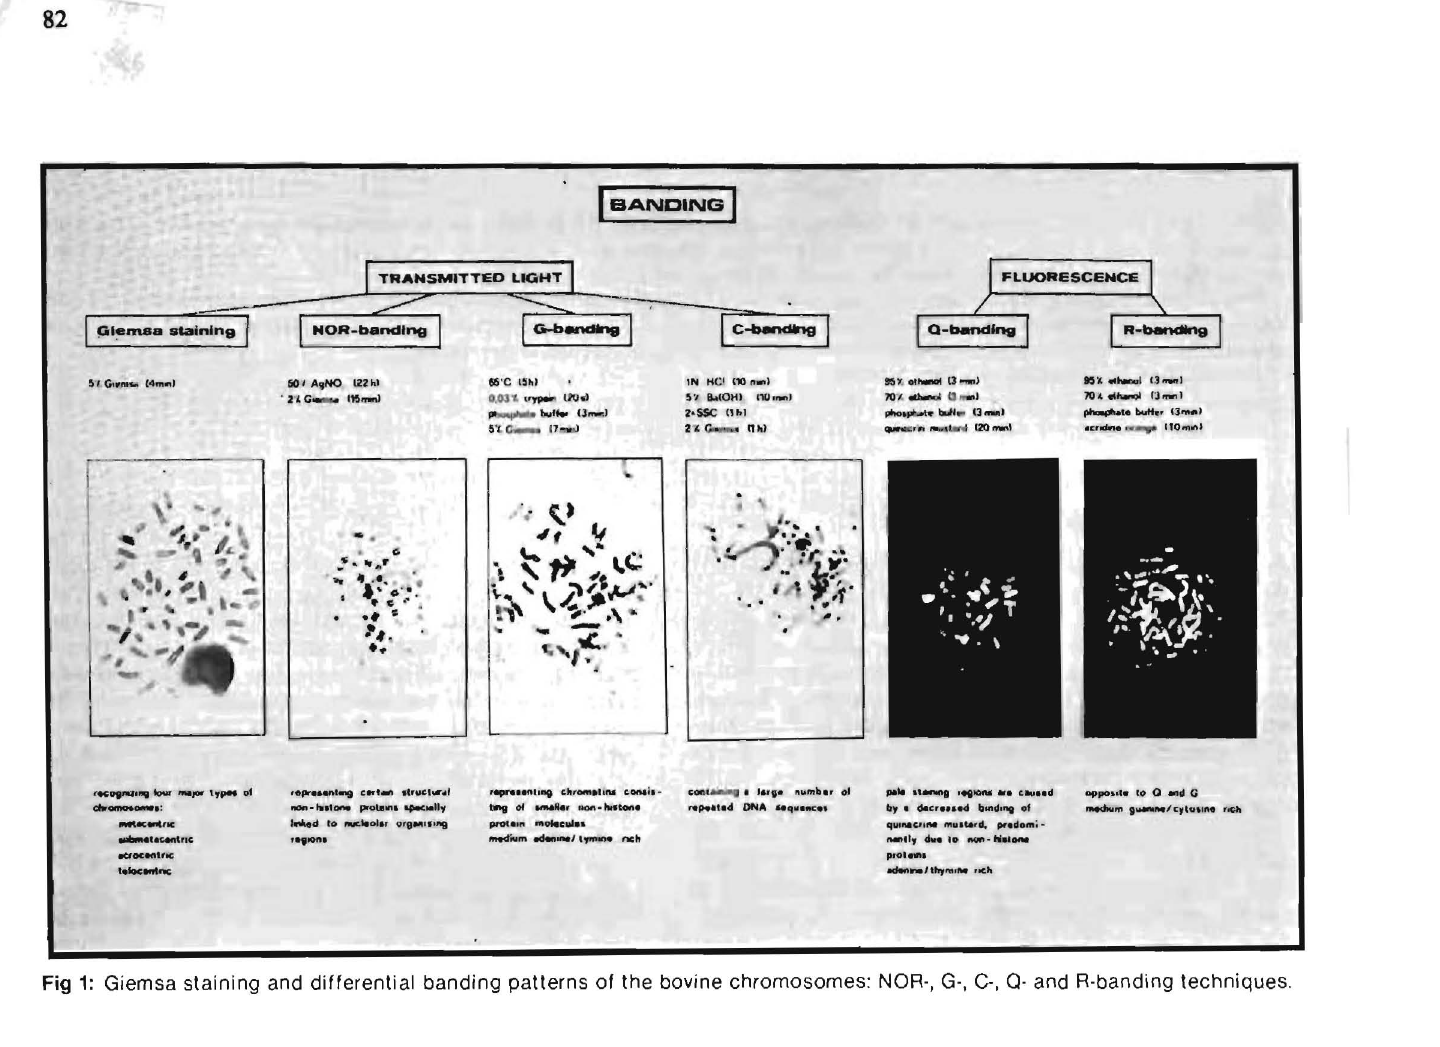
Fig 1: Giemsa staining and differential banding patterns of the bovine chromosomes: NOR-, G-, C-, 0- and R-banding techniques.